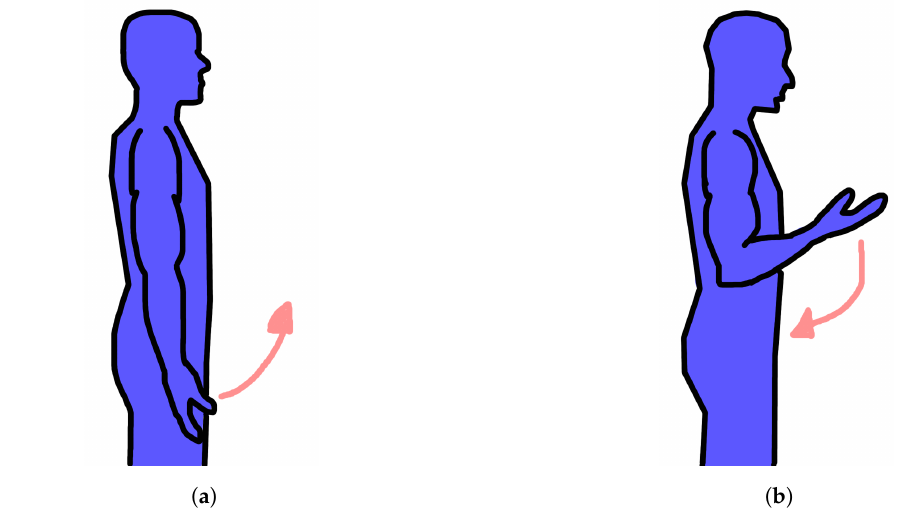
Figure 8. Movements made in the elbow test: ( a ) flexion; and ( b ) extension.